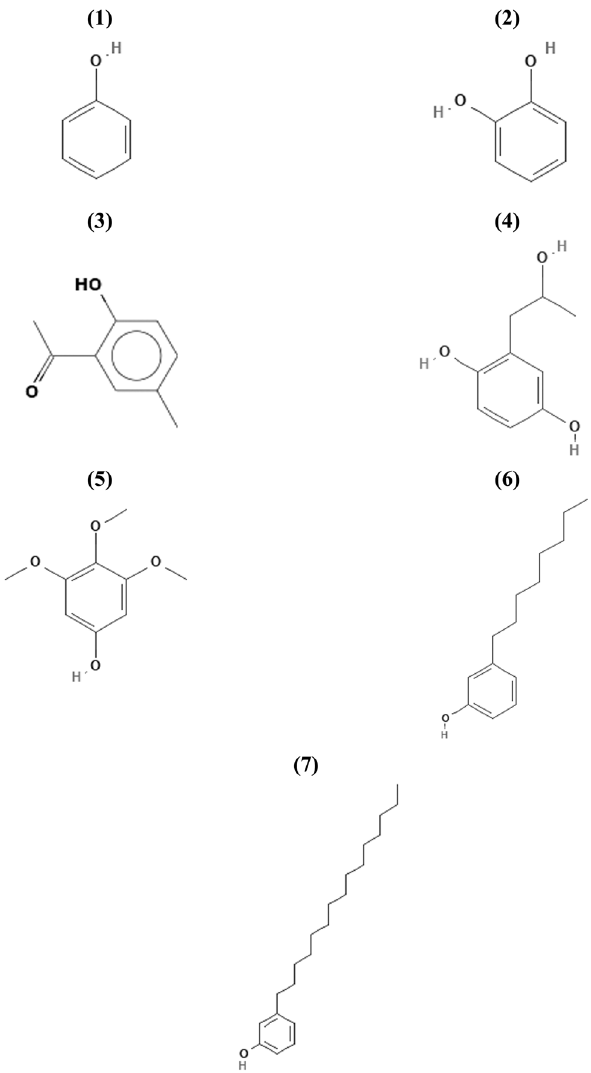
Figure 2: Chemical structures of identi fi ed phenols: ( 1 ) phenol, ( 2 ) 3 o - cathecol ( 1,2 - benzenediol ) , ( 3 ) 1 -( 2 - hydroxy - 5 - methylphenyl ) ethanone, ( 4 ) 2,5 - dihydroxy - α - methyl - phenetyl alcohol, ( 5 ) 3,4,5 - trimethoxyphenol, ( 6 ) 3 - octylphenol, ( 7 ) 3 - pentadecyl -